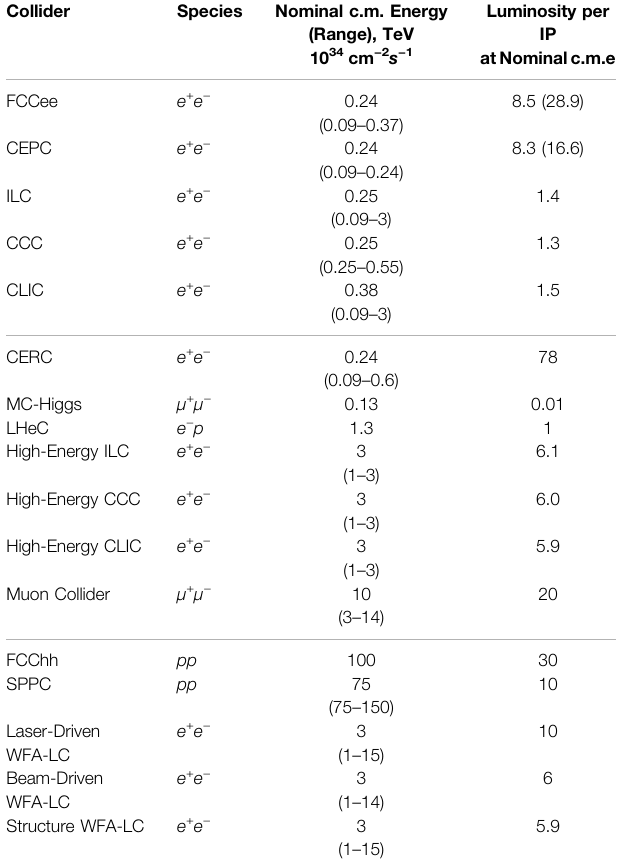
TABLE 1 | HEP Collider proposals: near-term, medium-term, and longer-term.